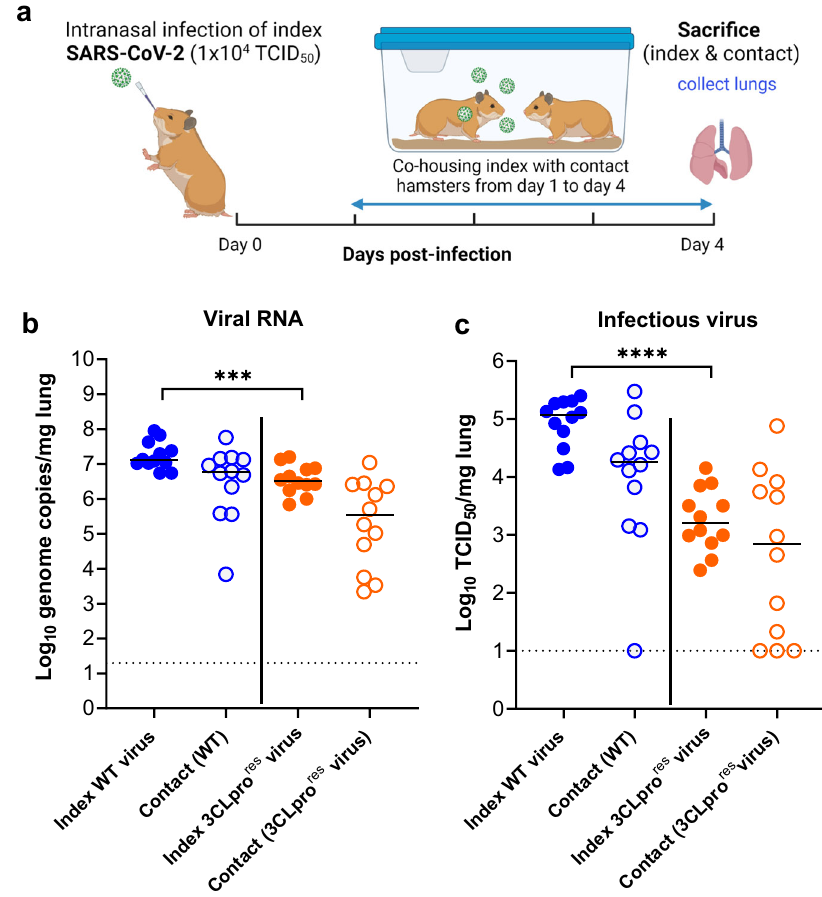
Fig.1|Theeffectof3CLprosubstitutions,thatareassociatedwithnirmatrelvir- resistance, on viral transmission to contact hamsters. a Set-up of the study. b Viral RNAlevels in the lungs ofindexhamsters infectedwith 10 4 TCID 50 of either the wild-type (WT) SARS-CoV-2 isolate (USA-WA1/2020) or the 3CLpro (L50F- E166A-L167F) nirmatrelvir resistant (3CLpro res ) virus (closed circles) and contact hamsters (open circles) at day 4 post-infection (pi) are expressed as log 10 SARS- CoV-2 RNA copies per mg lung tissue. Individual data and median values are